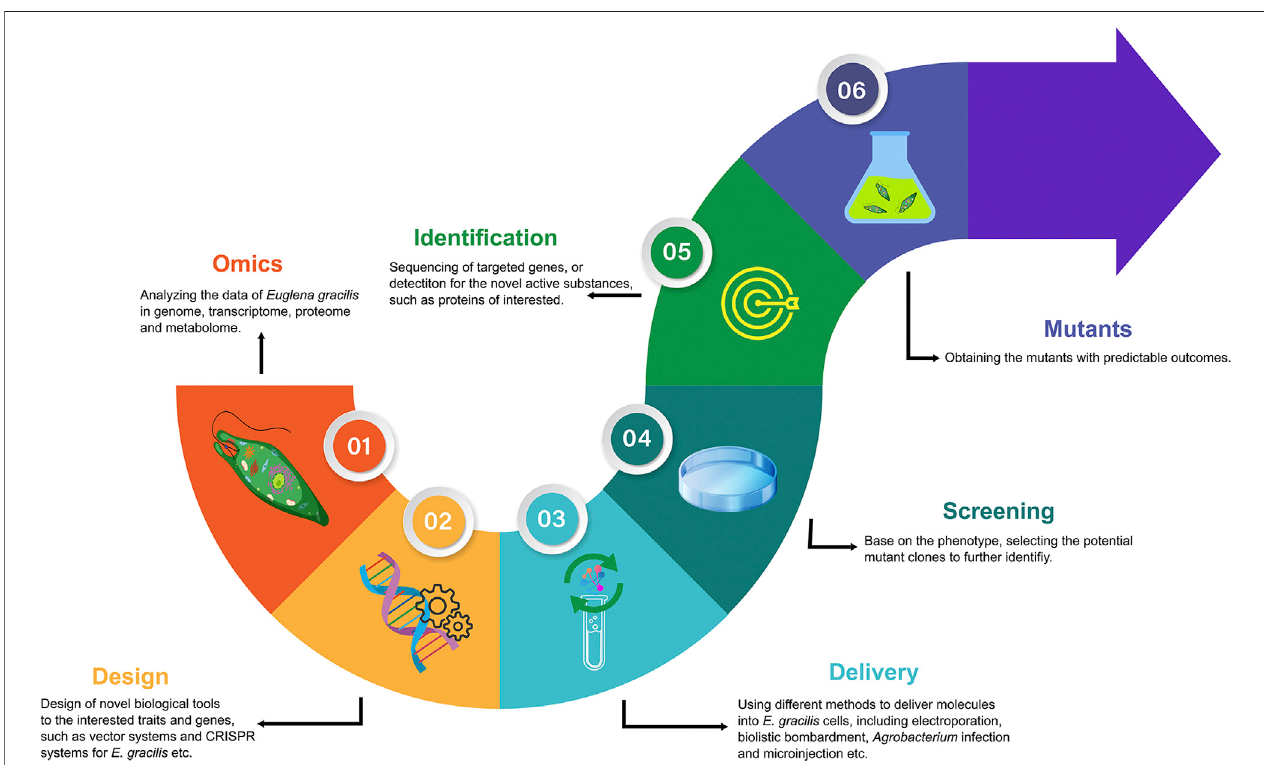
FIGURE 1 | Schematic fl owchart of a bioengineering work fl ow on synthetic biology for E. gracilis .